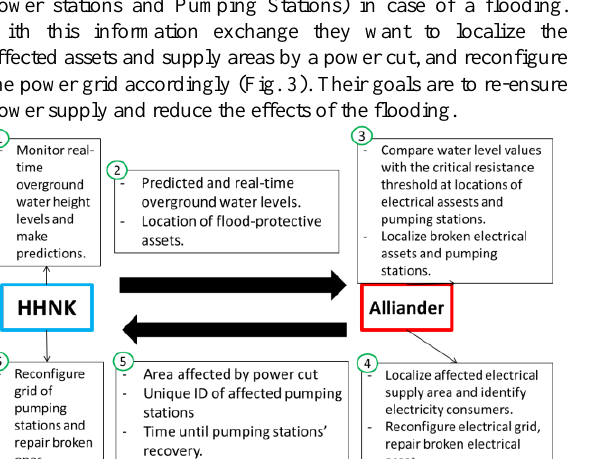
Figure 3: Information exchange between Alliander and HHNK during a flood-caused power